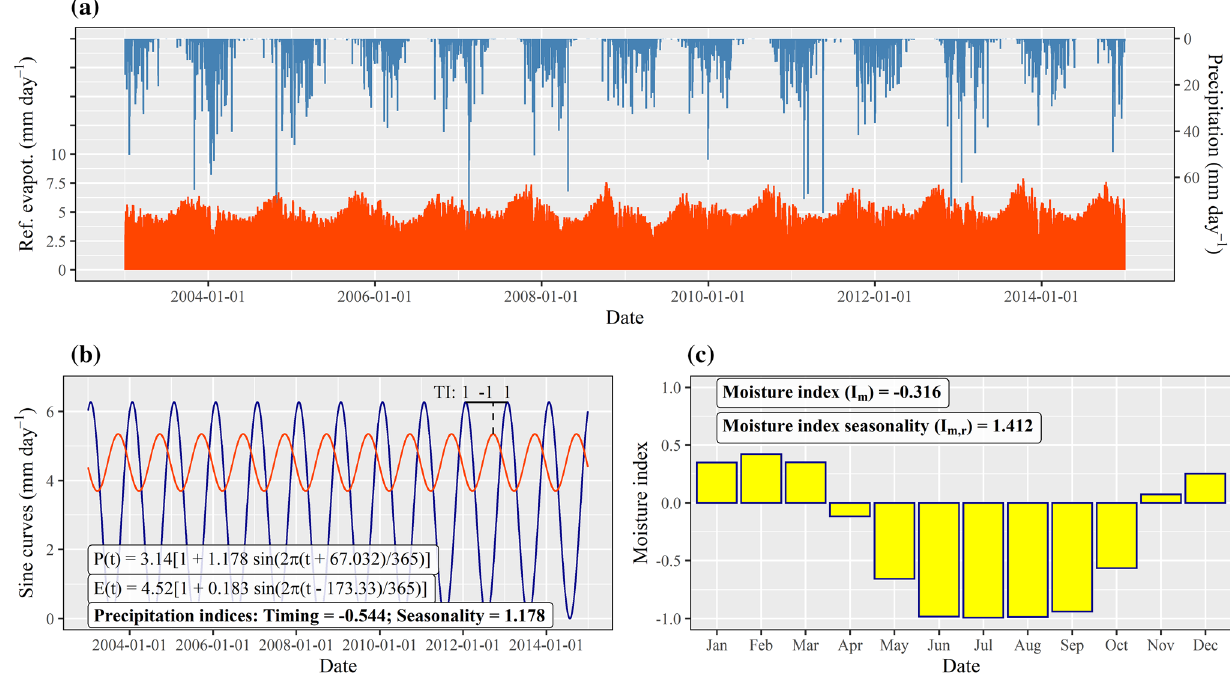
Fig. 3 Time series of a precipitation and reference evapotranspiration, b their respective sine curves, and c monthly moisture index for an arbi- trary ottobasin (ID =